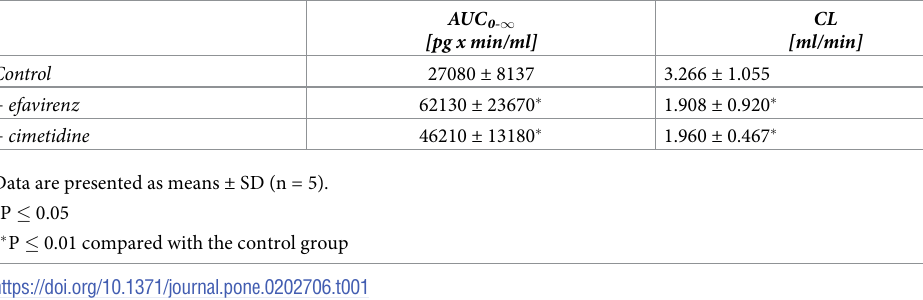
Table 1. Effects of efavirenz and cimetidine on the pharmacokinetics of lamivudine in rats.